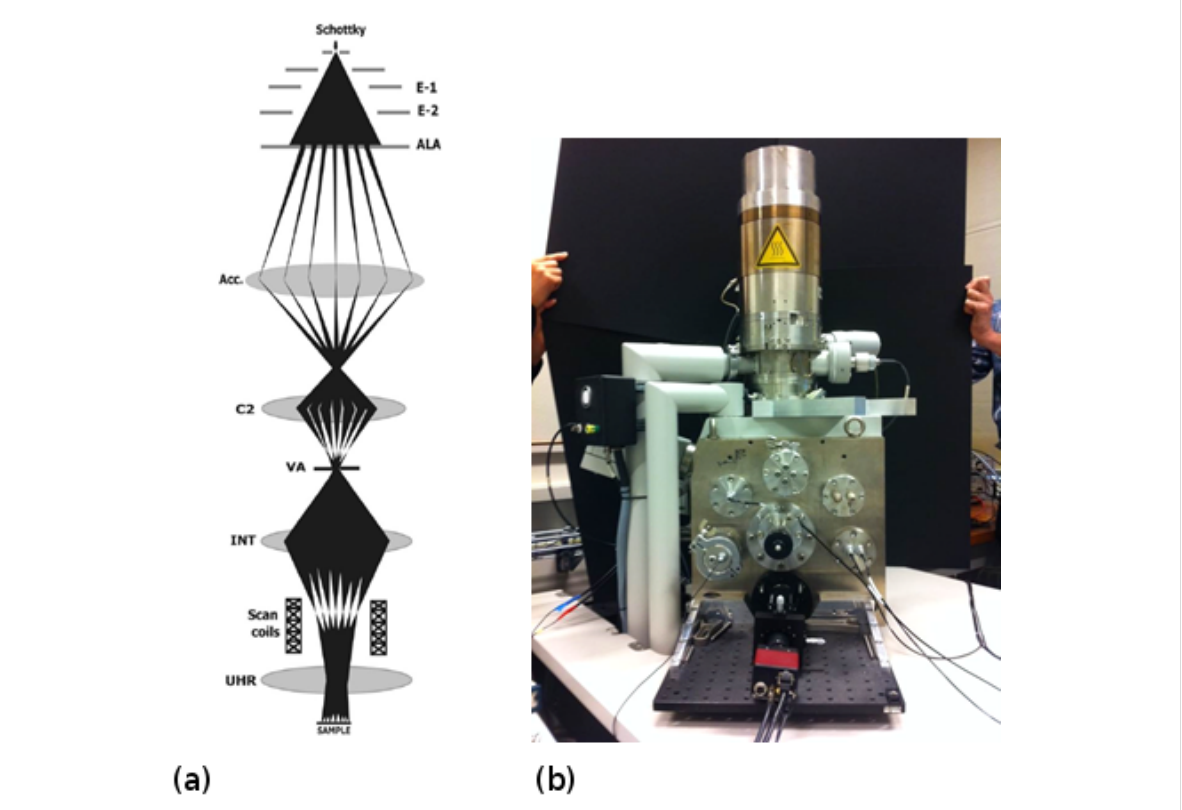
Figure 9: (a) Schematic of the multibeam EBL system at TU Delft [45,46]. (b) Experimental multibeam tool using a Nova Nano SEM from FEI Co as platform.